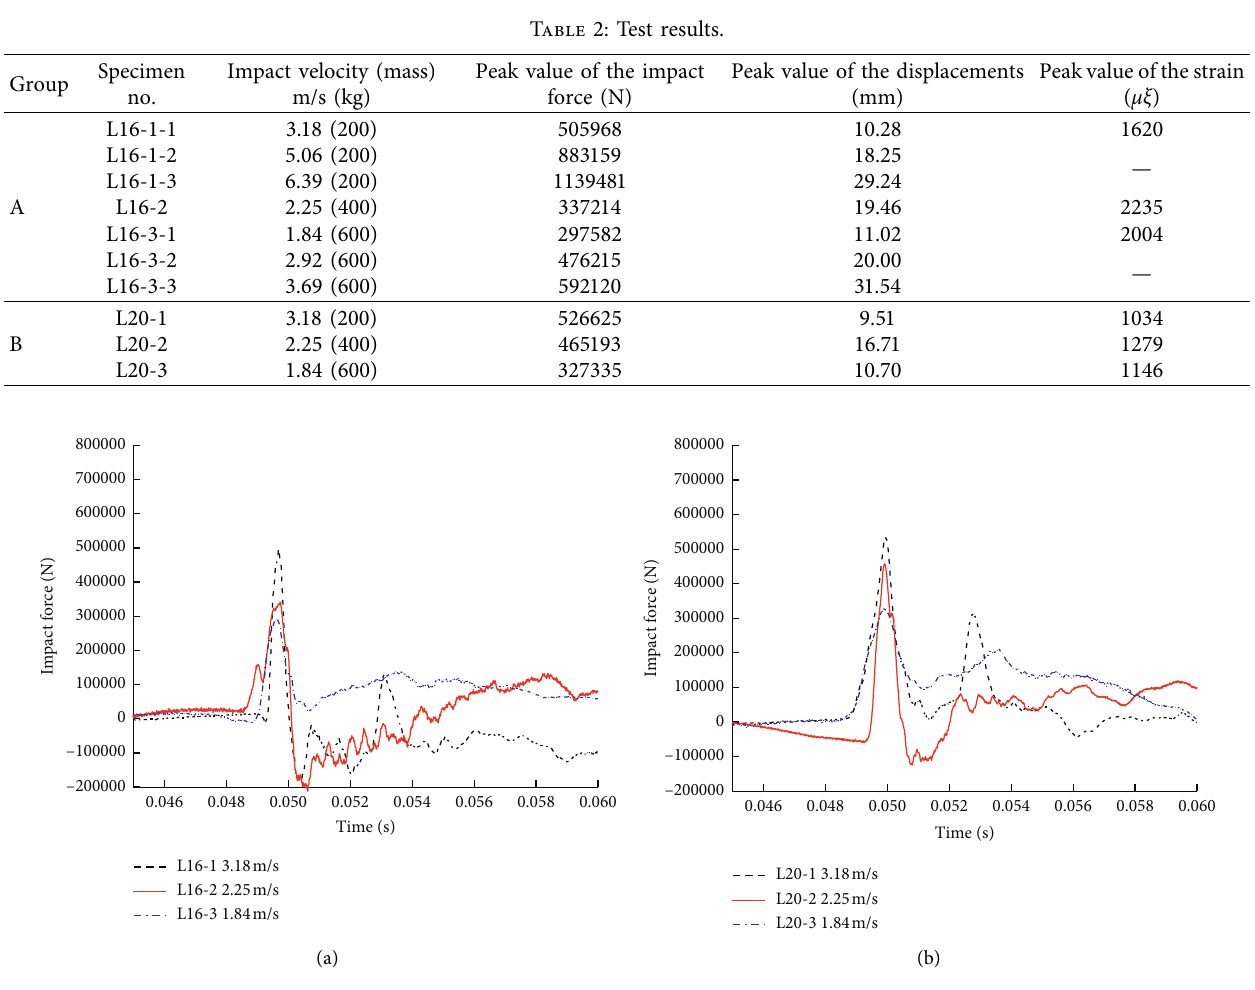
Figure 3: Time-history curves of the impact force: (a) Group A; (b) Group B.